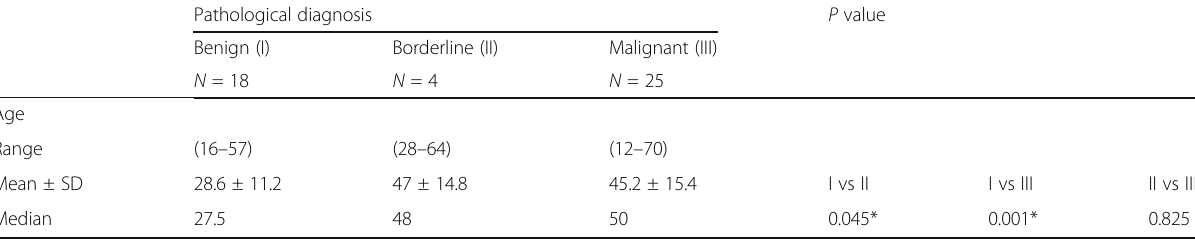
Table 1 Correlation between patient age and final pathological diagnosis of 47 patients with ovarian tumors Pathological